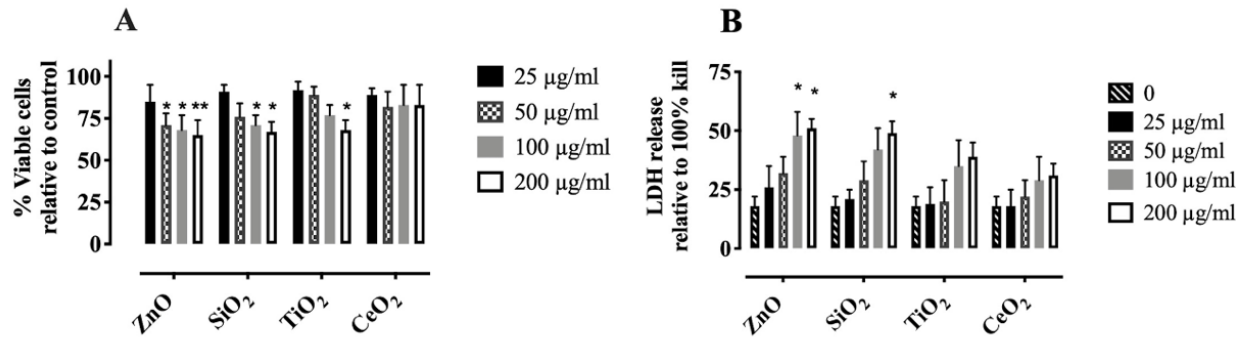
Figure 1. Toxicity in AMattributable to NP and SiO2. AM were incubated with individual particles for 4 h at 37 °C. Results from the ( A ) MTS assay after incubation of particles with AM, ( B ) LDH assay. Data are presented as means ± SEM of triplicate measurements. * and ** indicates significant effects ( p ≤ 0.05 and p ≤ 0.01, respectively). Data analyzed by two-way ANOVA using Holm–Sidak’s post hot test.